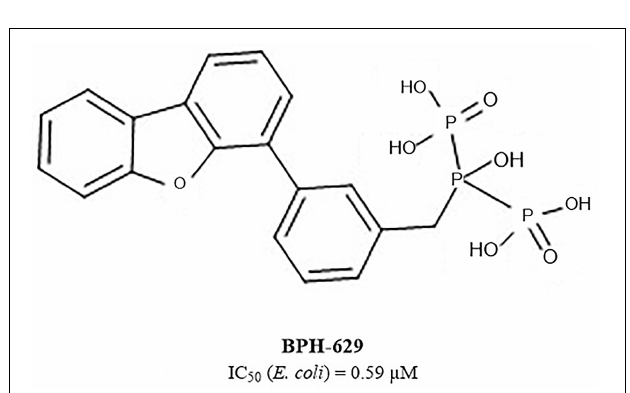
FIGURE 2 | Structure of bisphosphonate inhibitor